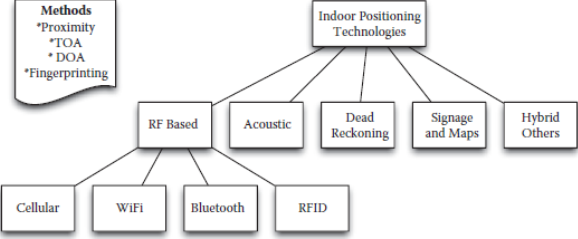
Figure 1. Positioning technologies and methods for indoor areas (Adapted from Krishnamurthy, 2015).